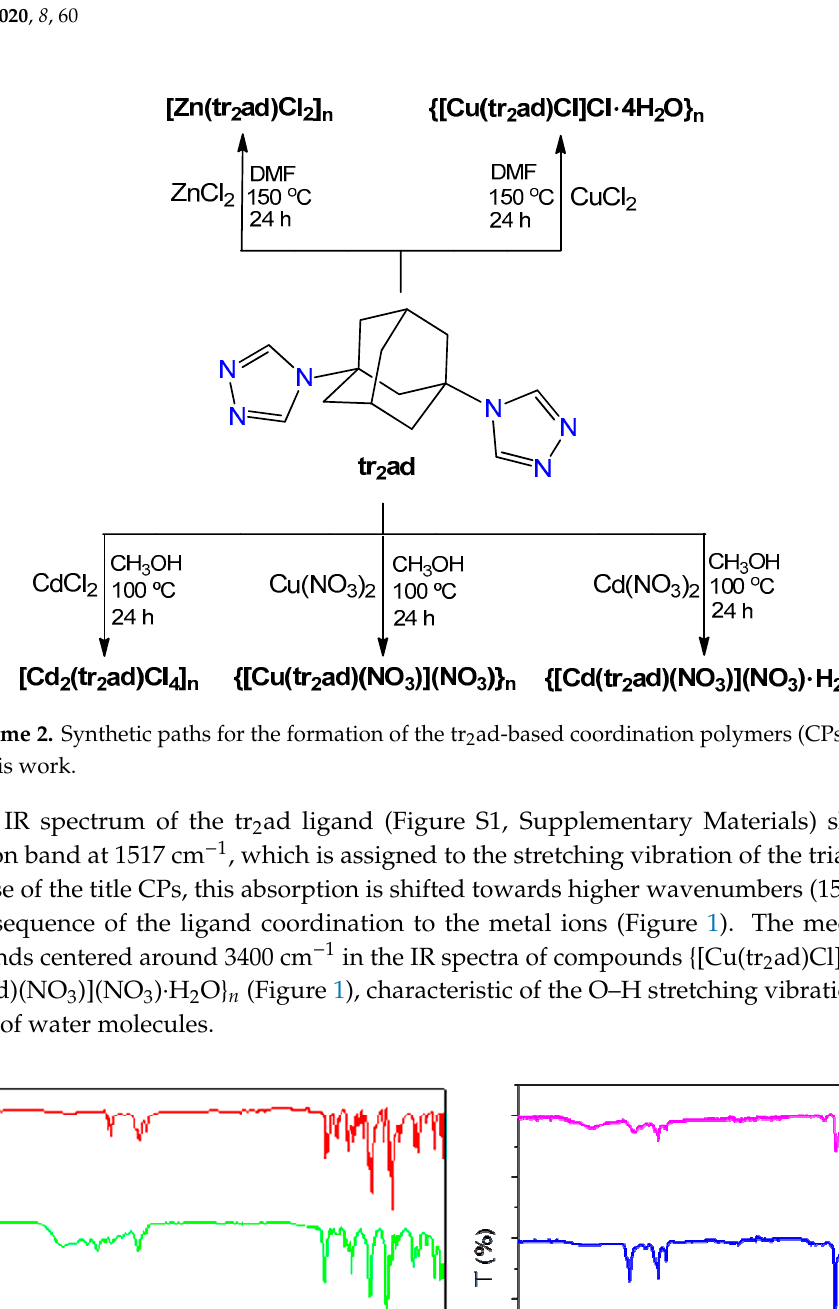
Figure 1. IR spectra of [Zn(tr 2 ad)Cl 2 ] n (black), {[Cu(tr 2 ad)Cl]Cl ∙ 4H 2 O} n (green), [Cd 2 (tr 2 ad)Cl 4 ] n (red), {[Cu(tr 2 ad)(NO 3 )](NO 3 )} n (blue) and {[Cd(tr 2 ad)(NO 3 )](NO 3 ) ∙ H 2 O} n (fuchsia).